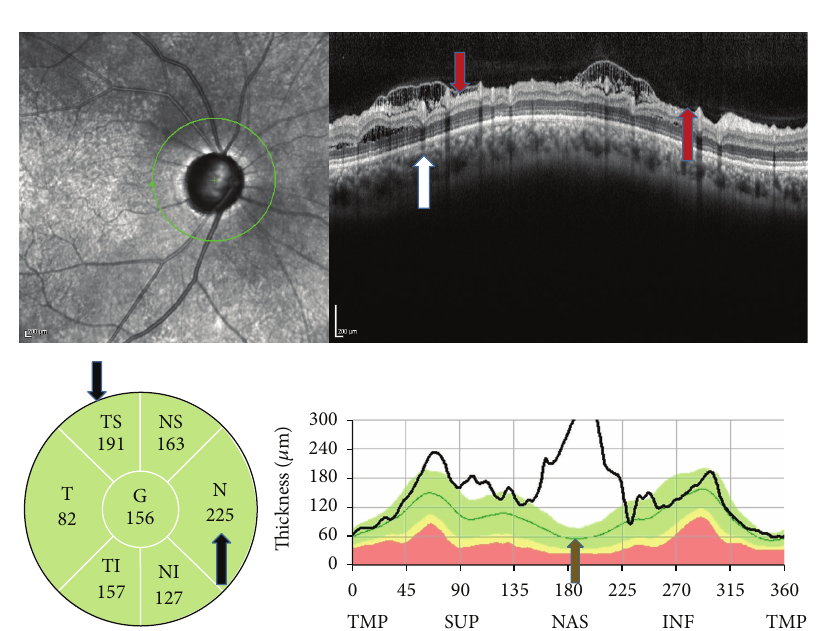
Figure 1: SD-OCT findings in a case of pseudoexfoliation glaucoma. The retinoschisis observed in the B-scan image (red arrows) in more than one sector and in different layers (white arrow), in the sector thickness map (black arrows), and in the TSNIT graphs (green arrow).